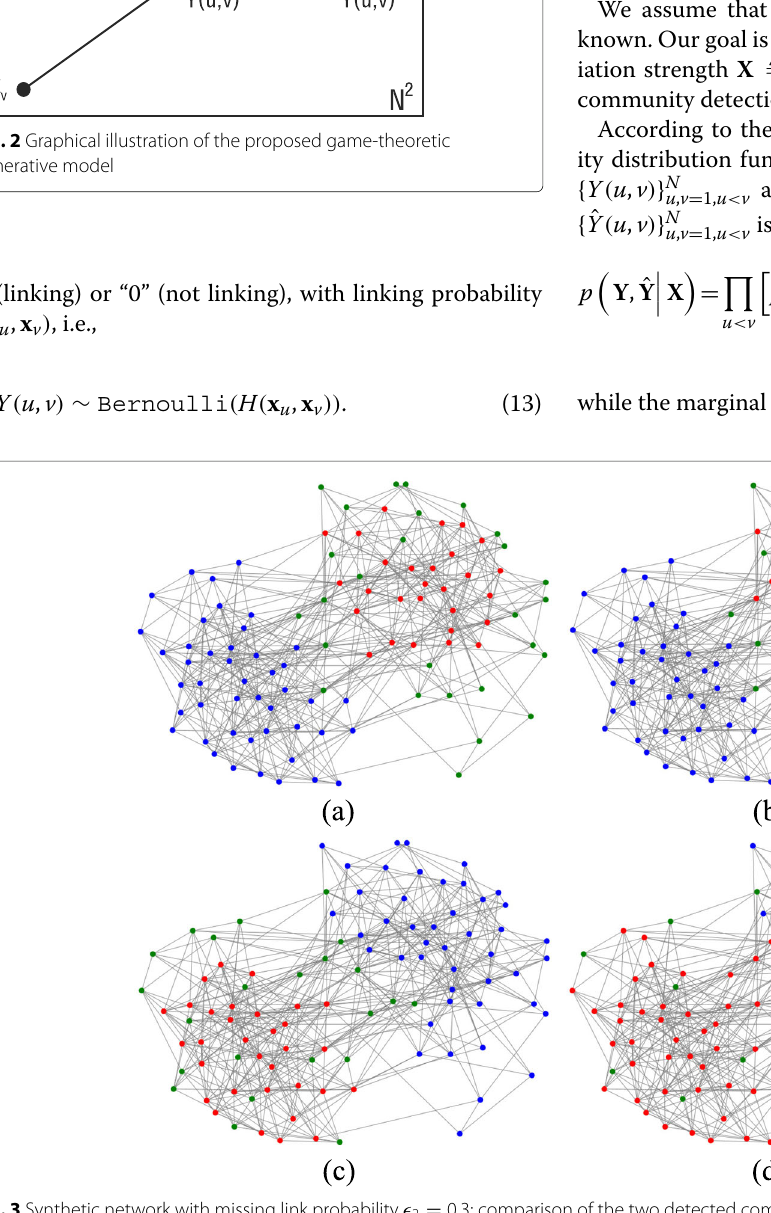
Fig. 3 Synthetic network with missing link probability (cid:3) 2 = 0.3: comparison of the two detected communities with the ground-truth by using the proposed noise-aware game-theoretic algorithm and the AGM in [15], respectively. Red nodes: belonging to the community and detected as in the community; blue nodes: not belonging to the community and detected as not in the community; green nodes: belonging to the community but detected as not in the community; black nodes: not belonging to the community but detected as in the community. There happens to be no black node in this network instance. a Detection of community 1 with AGM; b Detection of community 1 with the proposed noise-aware game-theoretic algorithm; c Detection of community 2 with AGM; d Detection of community 2 with the proposed noise-aware game-theoretic